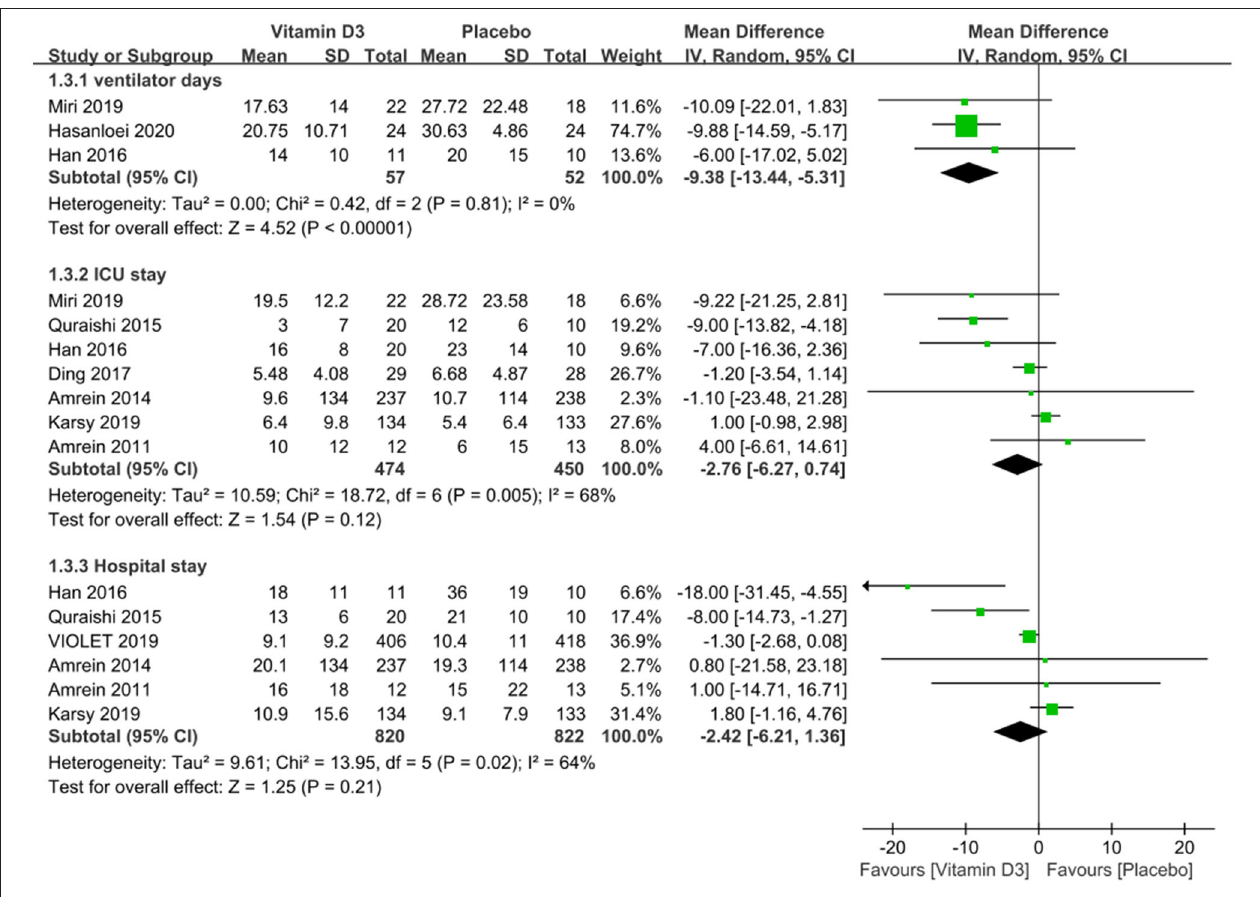
FIGURE 3 | The effect of vitamin D3 on the length of ICU stay and hospital stay in critically ill adult patients.